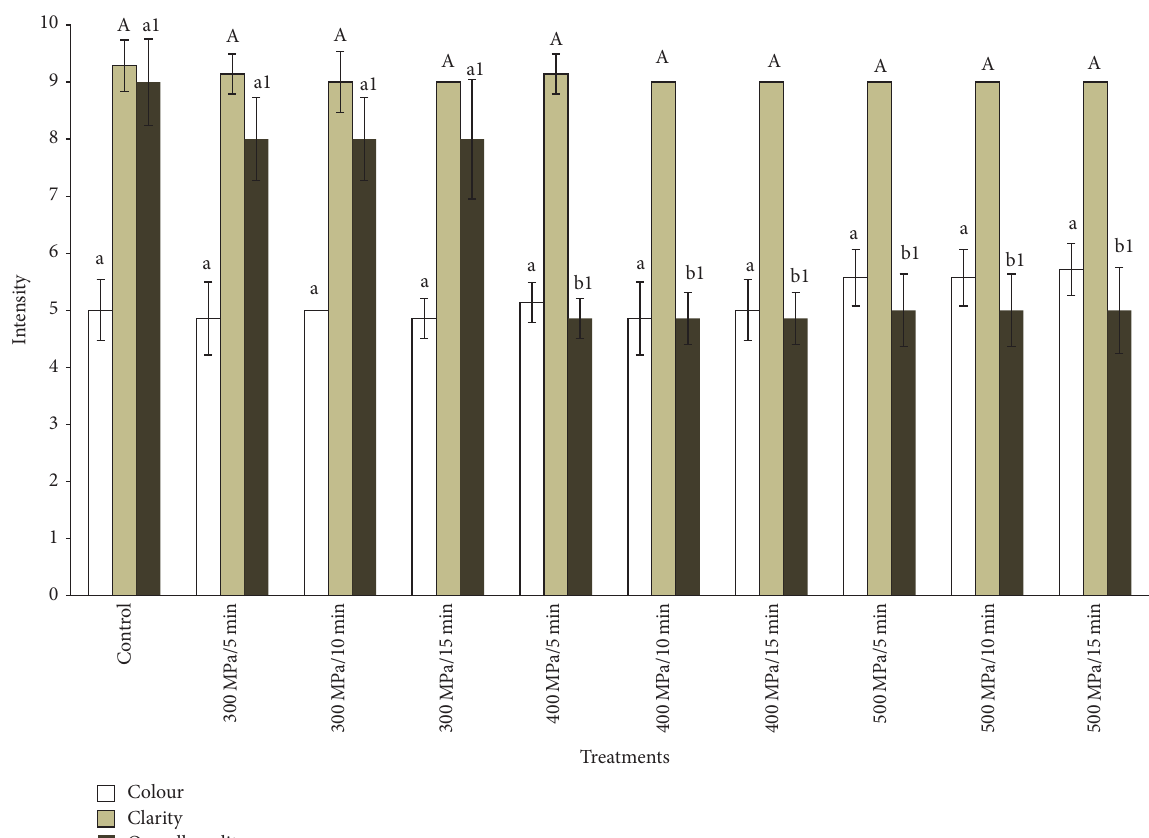
Figure 2: Effects of HHP on white wine sensory attributes. Different letters in each bar indicate significant differences between mean values ( 𝑝 ≤ 0.05